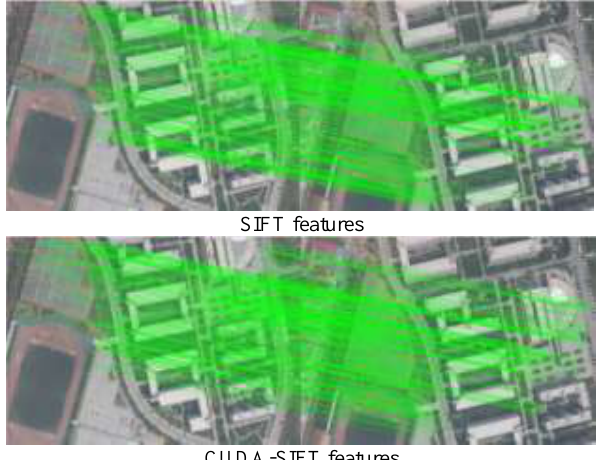
Fig. 3 Comparison of the matching performances between SIFT and the proposed CUDA-SIFT